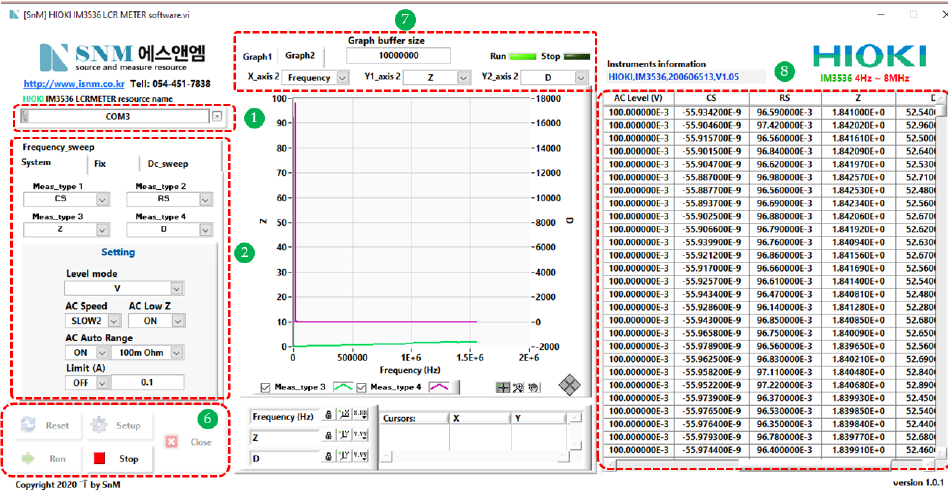
Figure 6. A detailed description of the computer aided software interface used in data collection with label from 1, 2, 6, 7 and